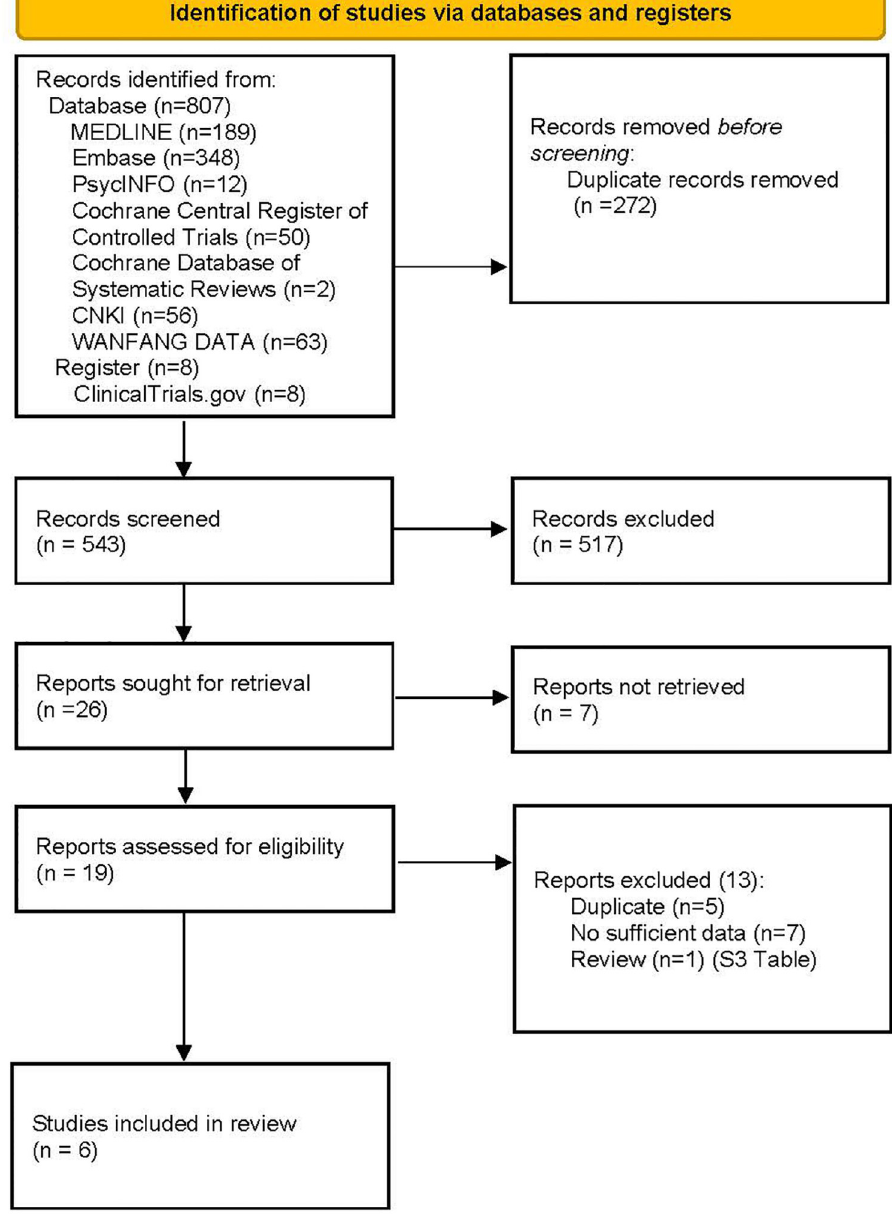
Fig 1. PRISMA 2020 flow diagram demonstrating the literature search and screening